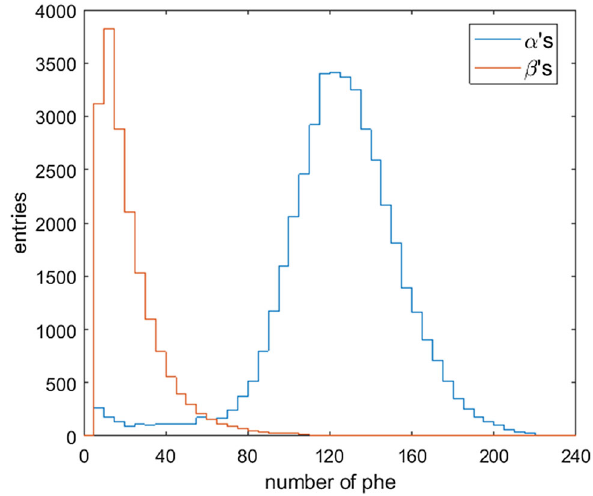
Fig. 6 Spectra (in number of detected photoelectrons) for the 90 Sr β - source (red) and for the 241 Am α -source (blue), obtained at 10 bar and high field conditions (above 50